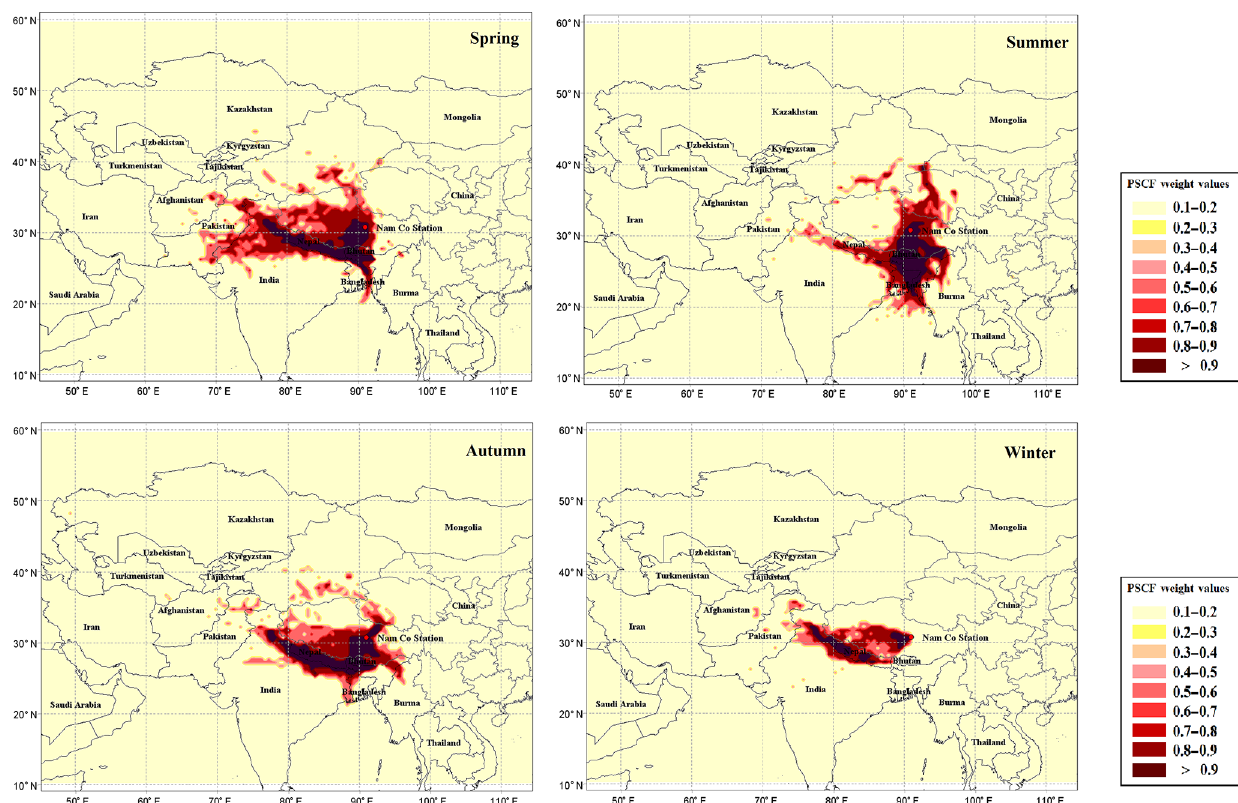
Figure 11. Potential source contribution function showing areas with possible emissions or air mass transport associated with higher TGM concentrations at Nam Co Station by season in